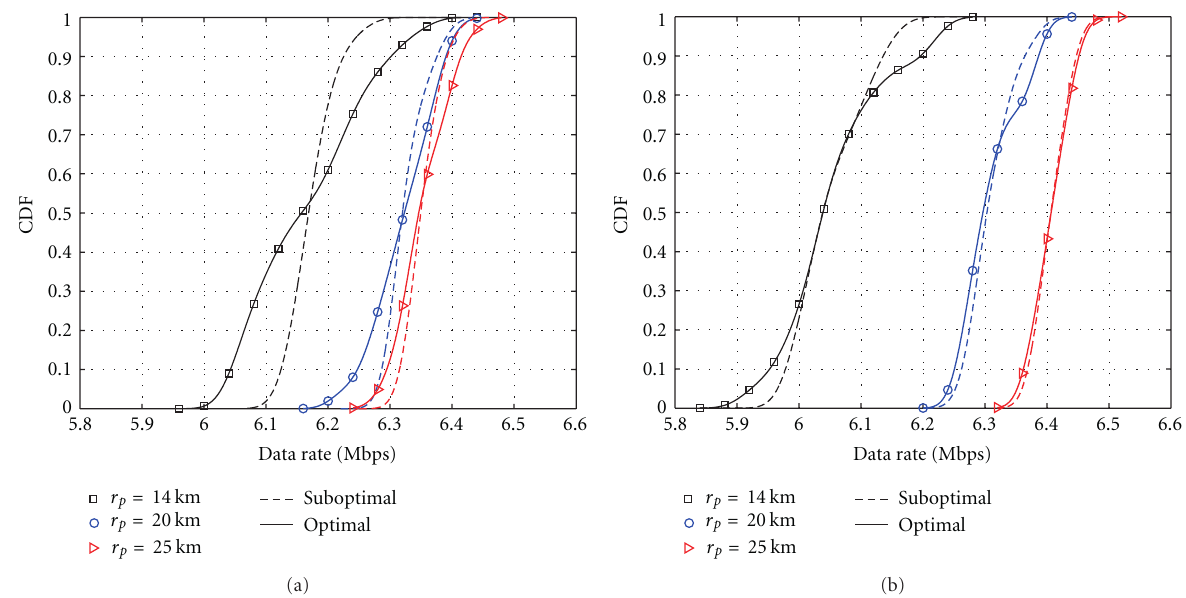
Figure 7: Distribution of average cell data rate by optimizing the transmission power for each base station and also by assuming equal transmission power for cells of the same size. (a) Upper part of secondary deployment area with cell radius 1 km. (b) Lower part of secondary deployment area with cell radius 2 km.